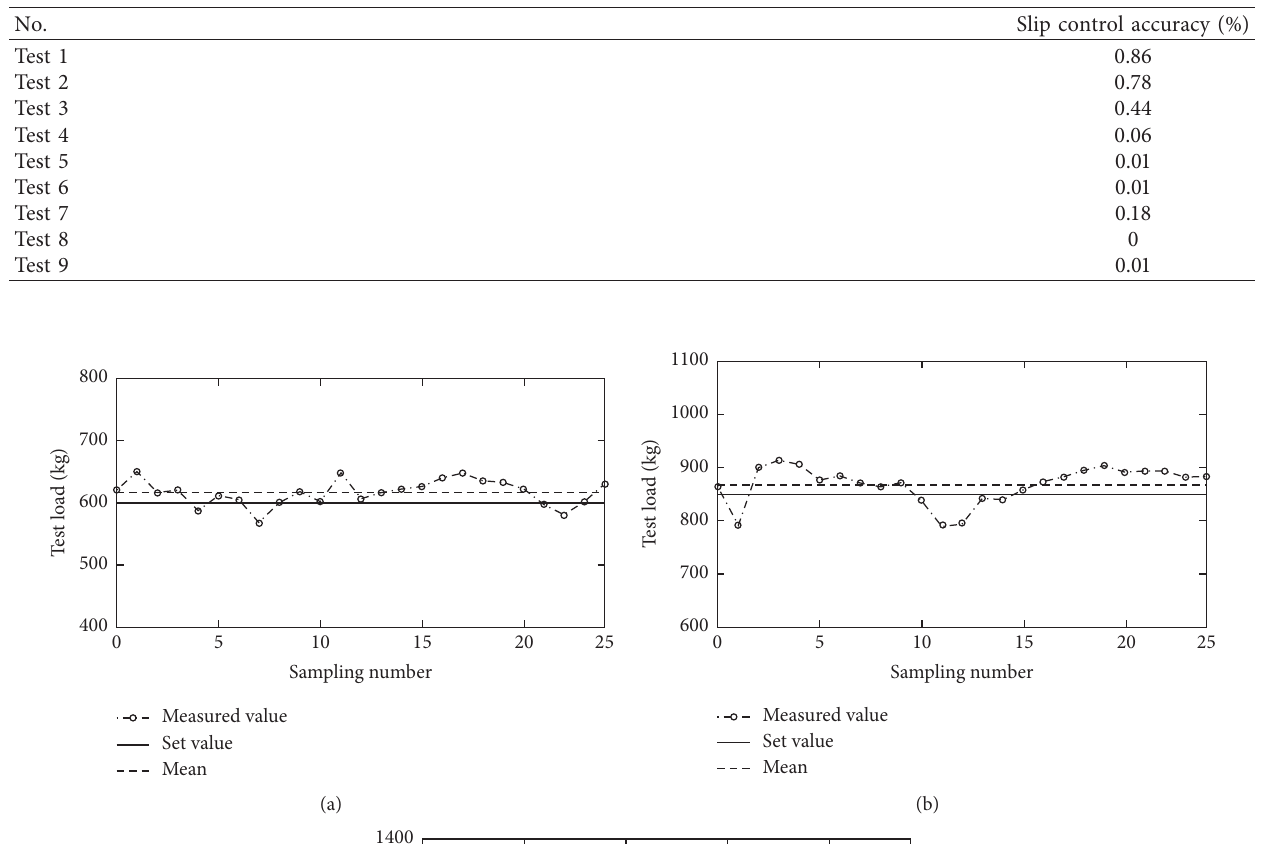
Table 5: Slip control accuracy